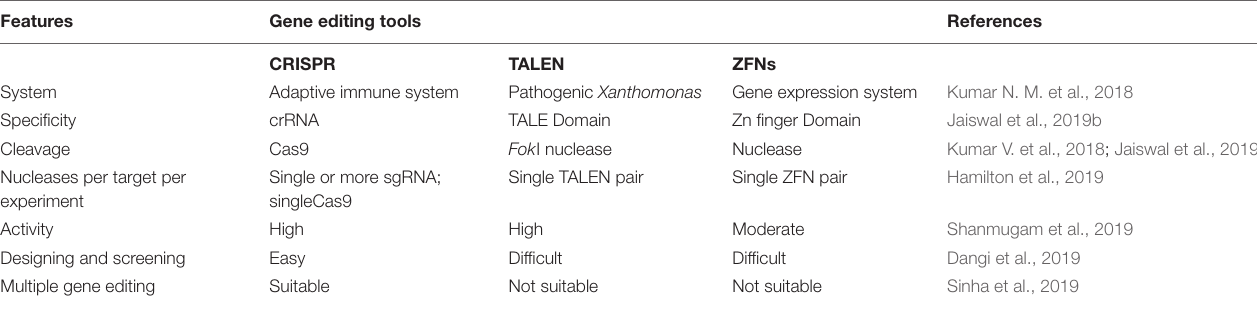
TABLE 2 | Comparative features of CRISPR, TALE, and